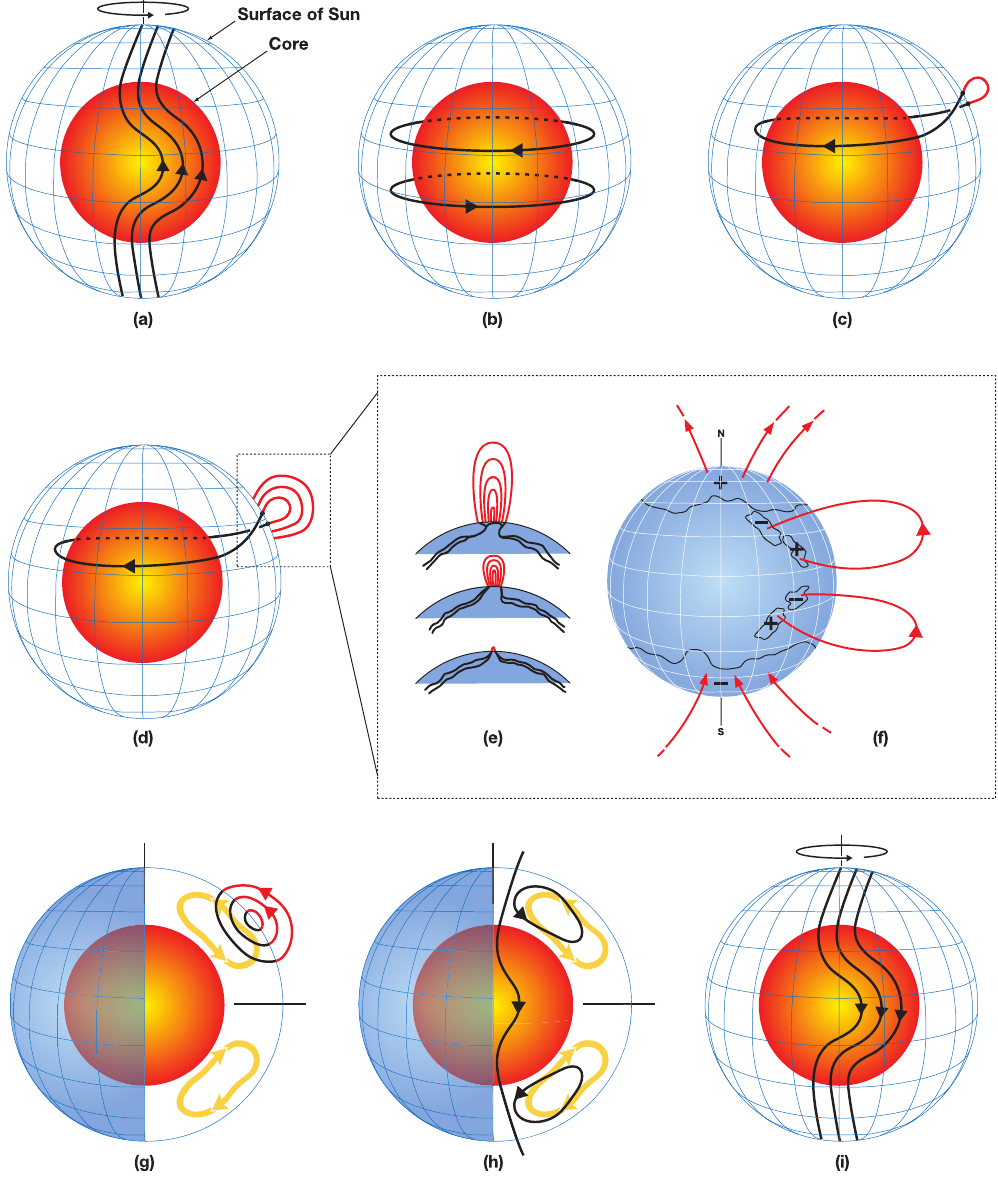
Fig. 2. Schematic of solar flux-transport dynamo processes. Red inner sphere represents the Sun’s radiative core and blue mesh the solar surface. In between is the solar convection zone where dynamo resides. (a) Shearing of poloidal field by the Sun’s differential rotation near convection zone bottom. The Sun rotates faster at the equator than the pole. (b) Toroidal field produced due to this shearing by differential rotation. (c) When toroidal field is strong enough, buoyant loops rise to the surface, twisting as they rise due to rotational influence. Sunspots (two black dots) are formed from these loops. (d, e, f) Additional flux emerges (d, e) and spreads (f) in latitude and longitude from decaying spots (as described in Fig. 5 of Babcock, 1961). (g) Meridional flow (yellow circulation with arrows) carries surface magnetic flux poleward, causing polar fields to reverse. (h) Some of this flux is then transported downward to the bottom and towards the equator. These poloidal fields have sign opposite to those at the beginning of the sequence, in frame (a). (i) This reversed poloidal flux is then sheared again near the bottom by the differential rotation to produce the new toroidal field opposite in sign to that shown in (b).